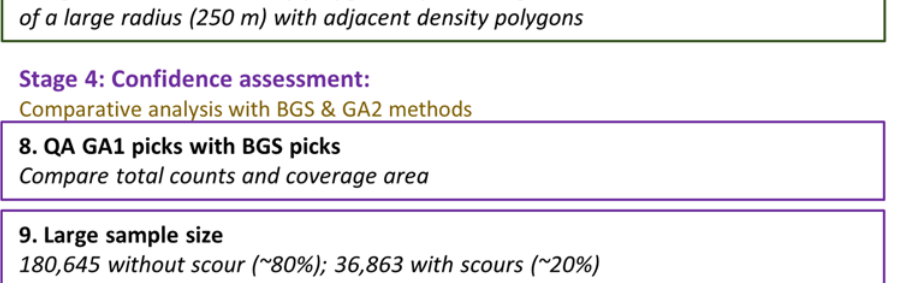
Figure 4. Summary steps involved in the extraction and characterisation of pockmarks. See supplementary material for